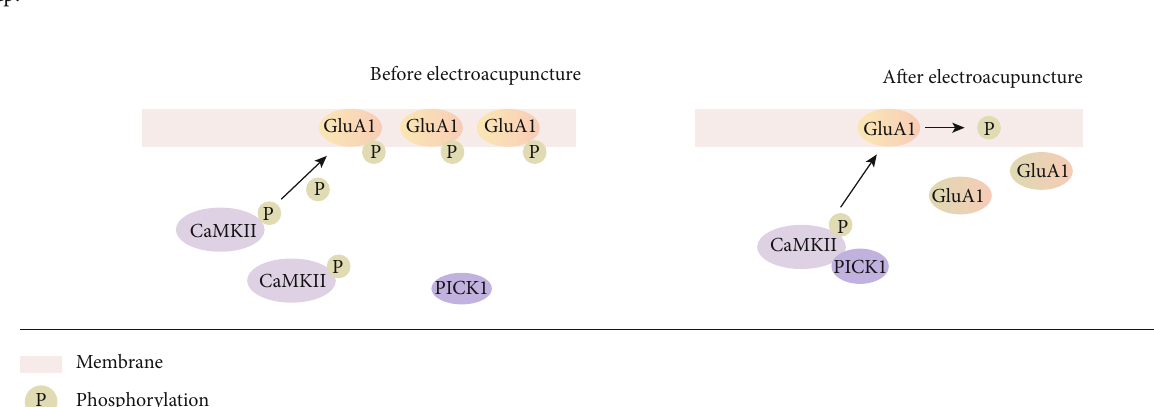
Figure 6: The antihyperalgesic mechanism of EA. EA treatment increases the amount of pCaMKII-PICK1 complexes. This prevents GluA1 phosphorylation, ultimately producing an anti-in fl ammatory pain e ff